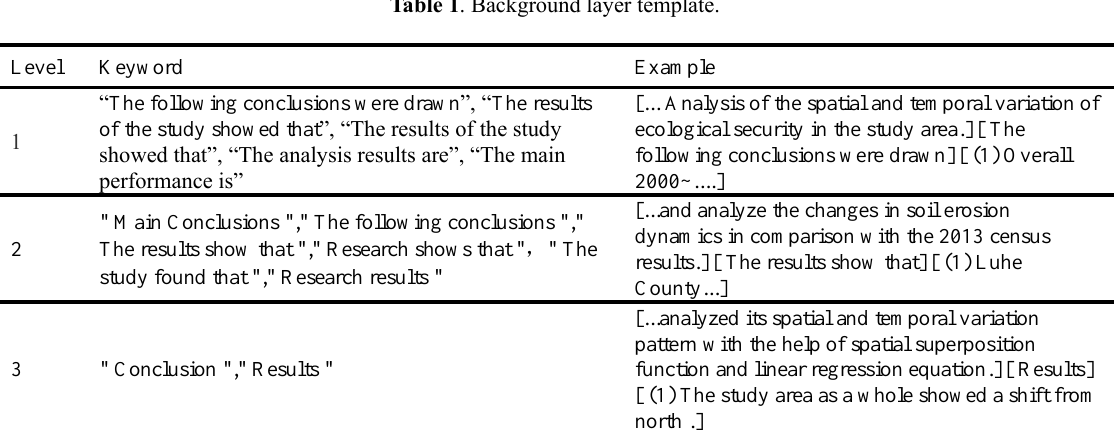
Table 2 . Result layer